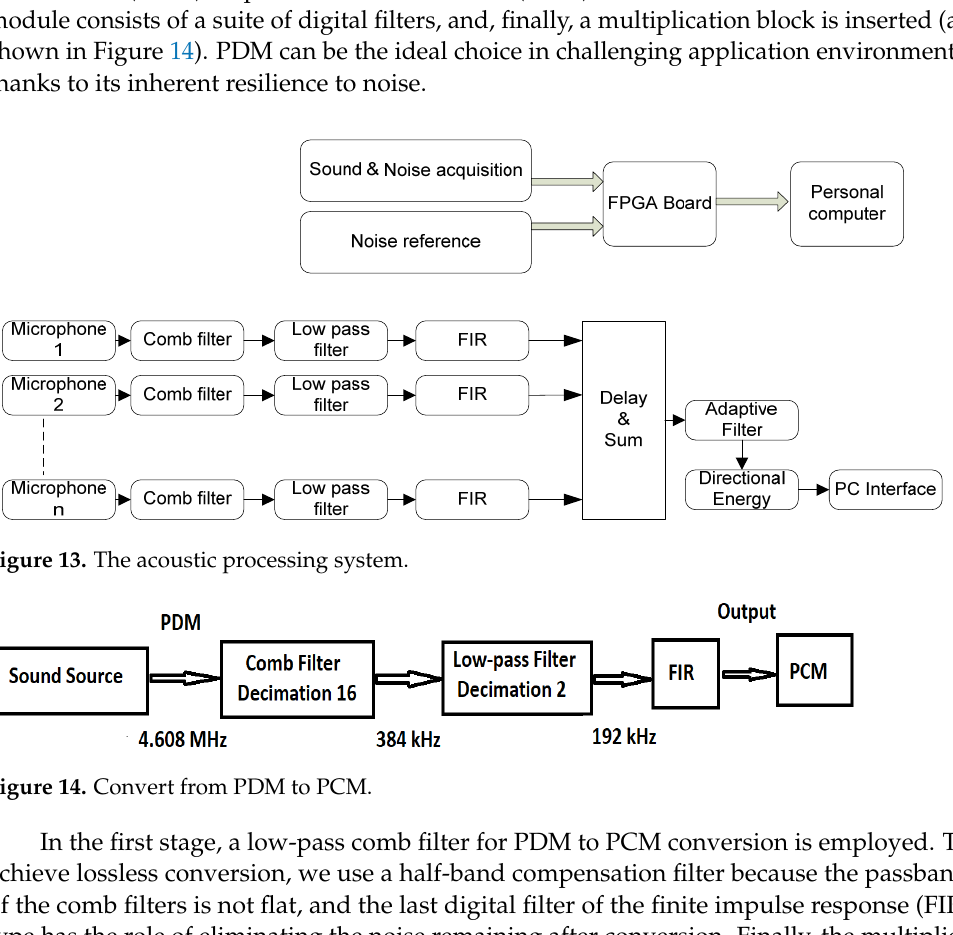
Figure 14. Convert from PDM to PCM.